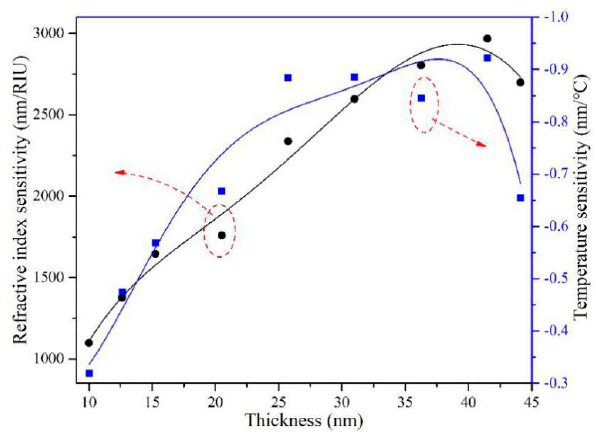
Figure 6. Refractive index and temperature sensitivities as functions of gold film